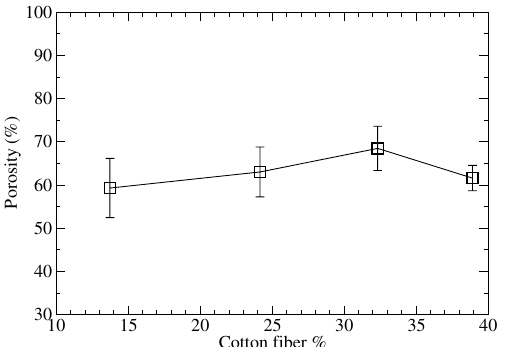
Figure 5. Porosity of the GDLs depending on the cotton fiber content. Error bars were determined from three different